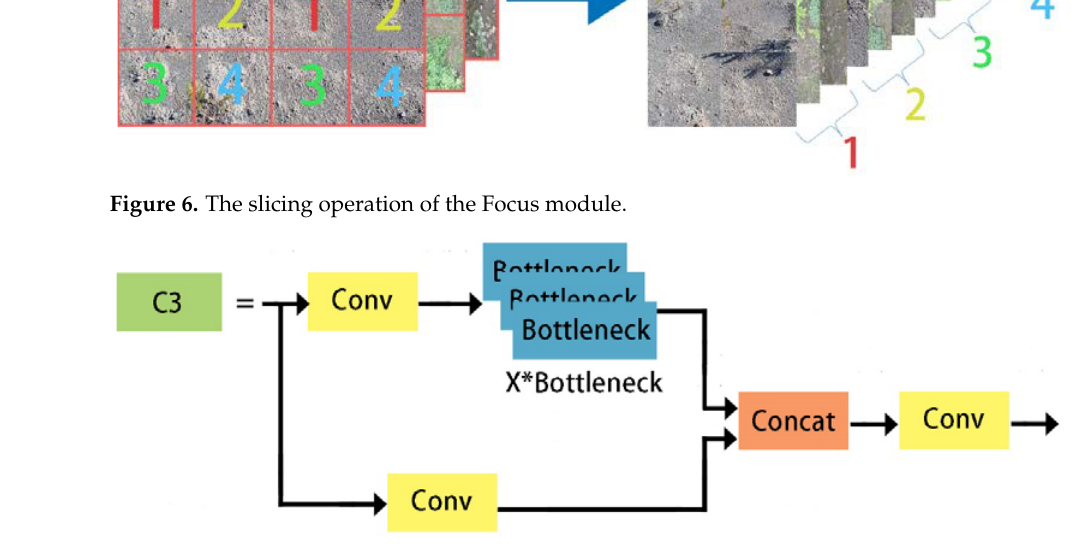
Figure 7. The structure of the C3 module.